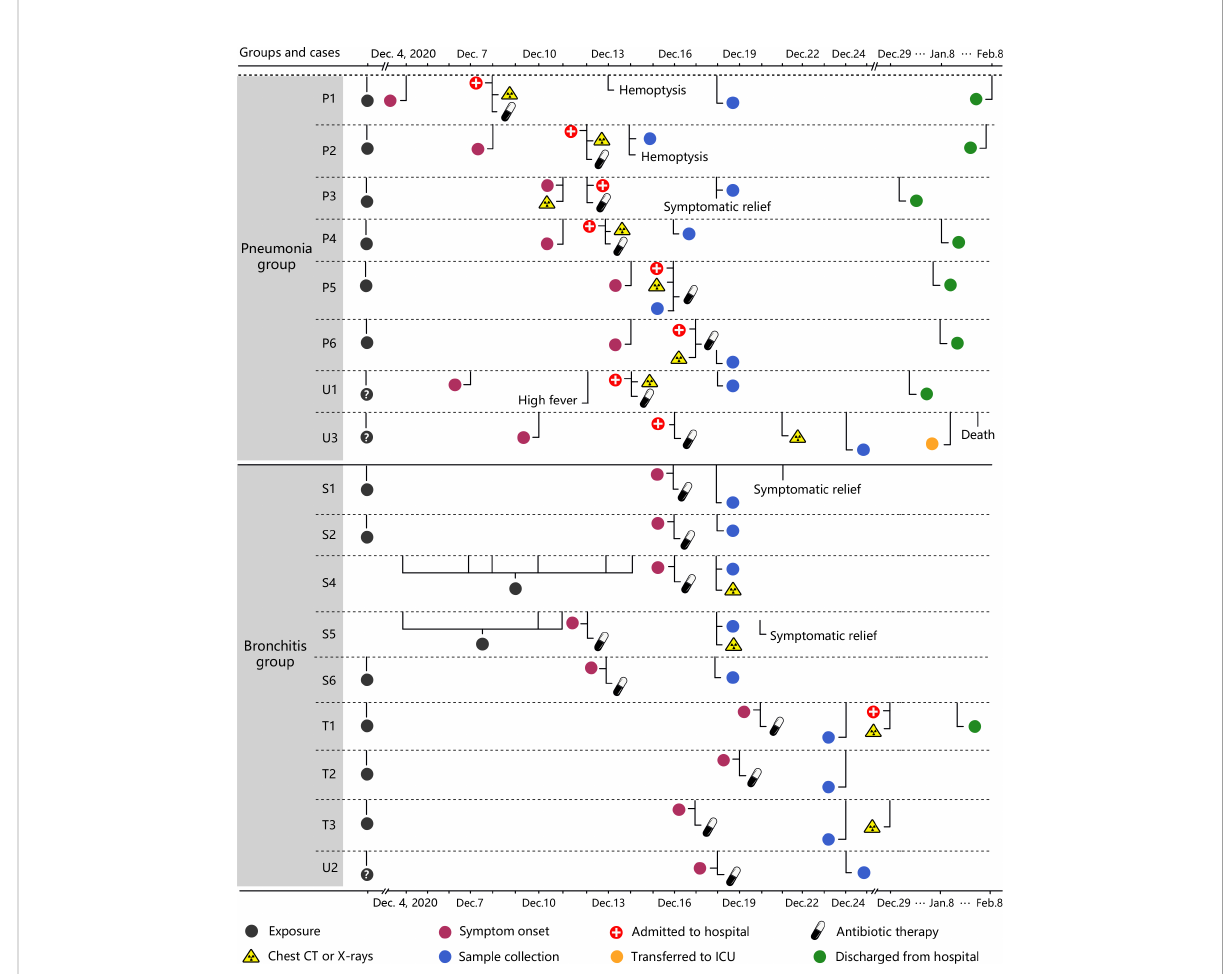
FIGURE 1 Timelines of the 17 C. psittaci cases. Each timeline represents one con fi rmed case from symptom onset to discharge from hospital. CPS: Chlamydia psittaci . P represents patients with primary infections. U represents patients with an unknown source of infection. S represents cases with secondary infections of C. psittaci . T represents third-generation